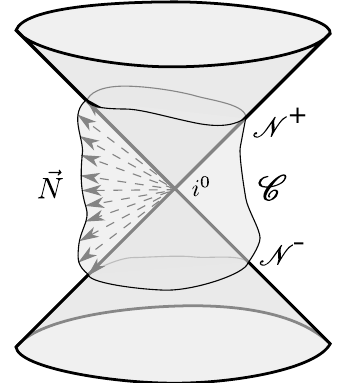
Figure 1 . The space C of null and spatial directions ~N at i 0 . The boundaries N ± ∼ = S 2 , diffeomorphic to the space of generators of I ± respectively, represent the space of null directions. C \ N ± is the space of rescaled spatial directions conformally diffeomorphic to the unit-hyperboloid H . C depends on the choice of the rescaling function Σ (defined below) and need not be a cylinder of unit radius in Ti 0 — a “wiggly” cylinder has been drawn here to emphasize